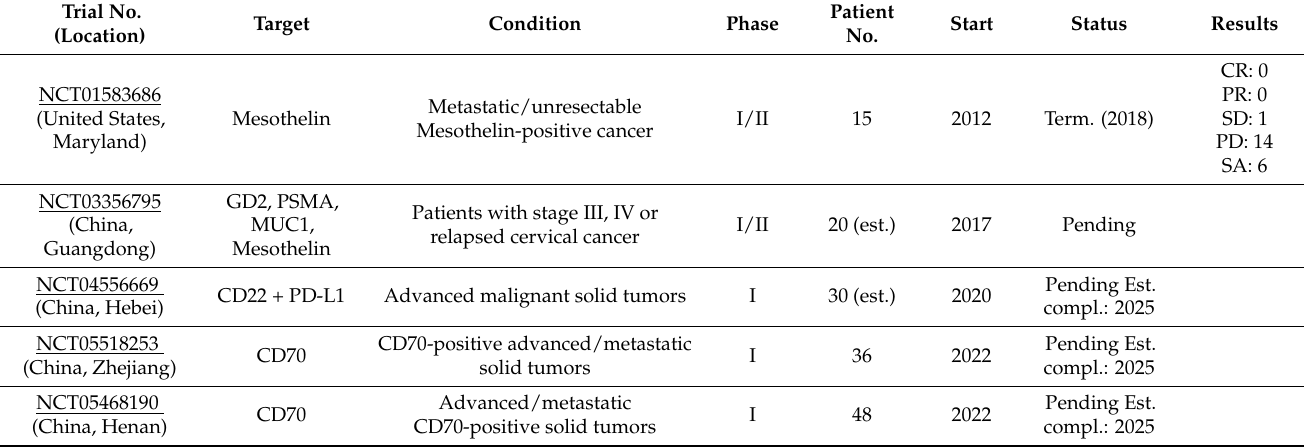
Table 1. CAR-T cell-based clinical trials against cervical